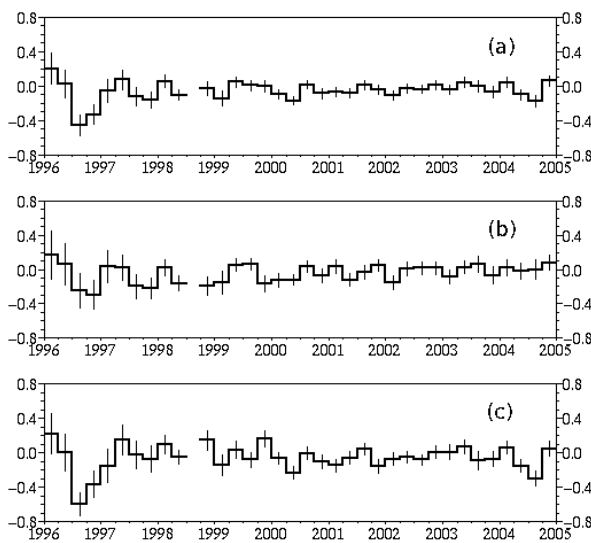
Fig. 4. East-west asymmetry in CME, calculated in 3-month pe- riods of SOHO LASCO observations, for all the data (a) , and for the Northern (b) , and the Southern (c) Hemispheres. The error bars represent 1 σ statistical